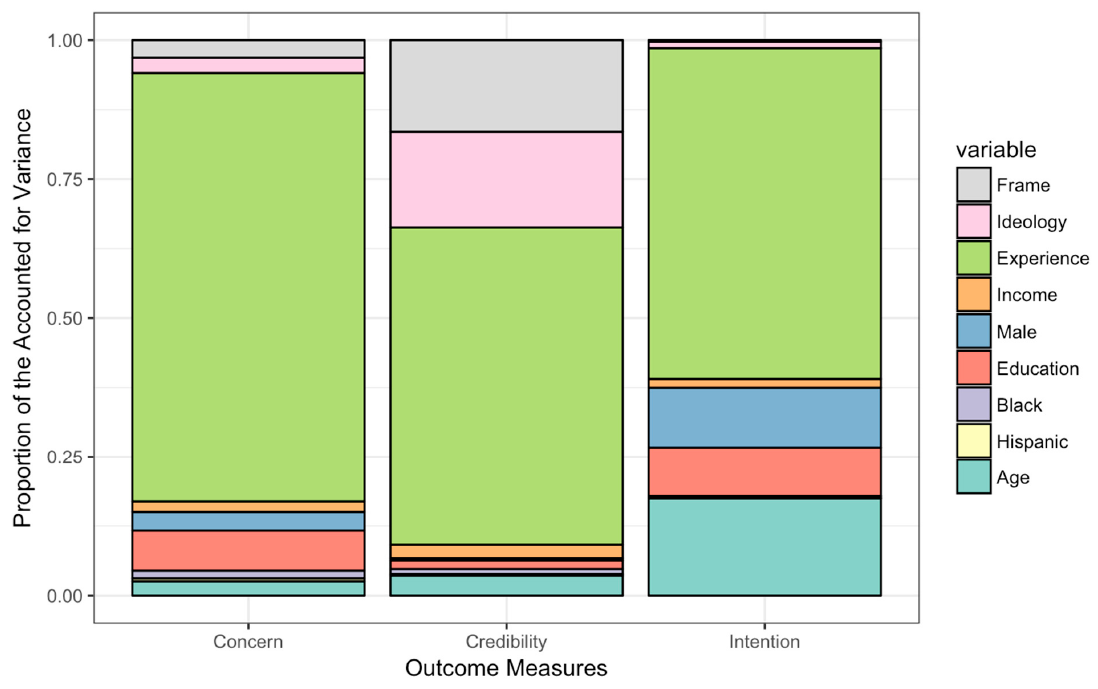
Figure 5. Visual representation of the proportion of the total variance accounted for that can be explained by each of the individual difference variables.